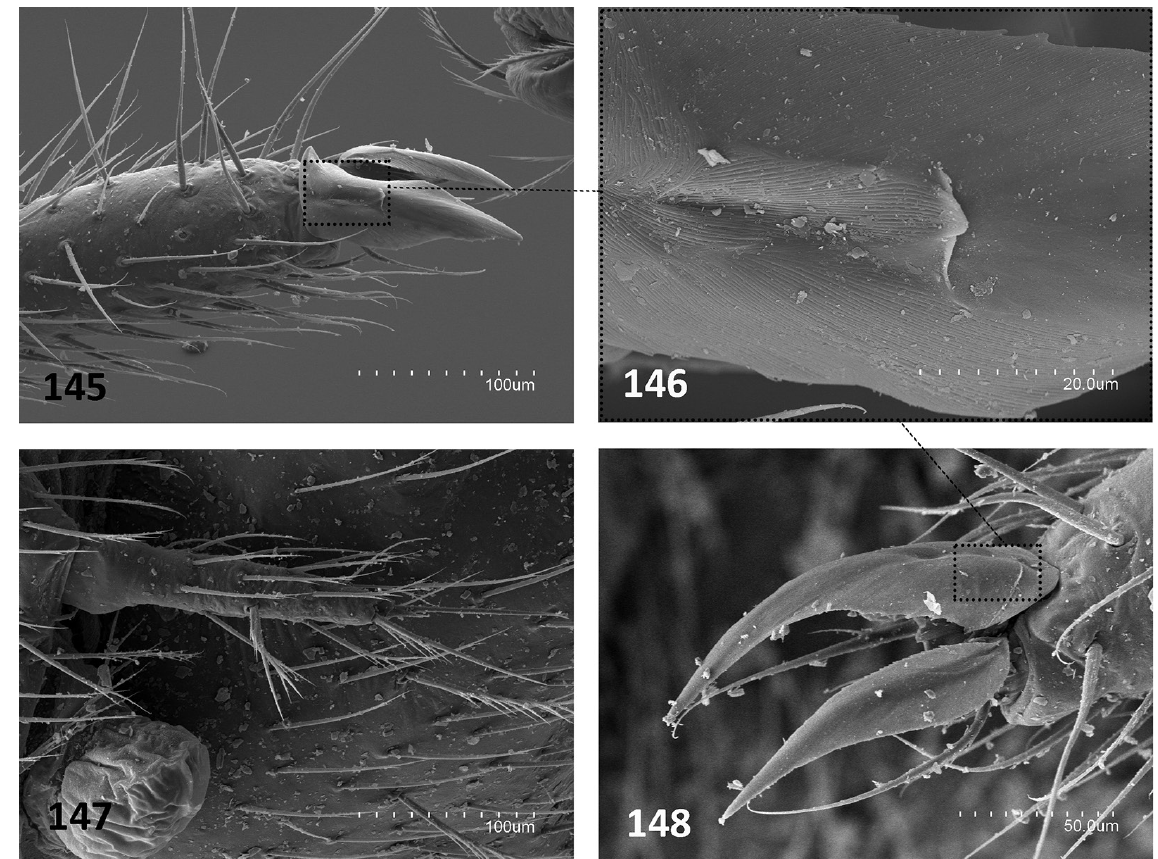
Figs 145–148. Plusiocampa ( Plusiocampa ) strouhali cavicola Vornatscher, 1943, from Odelsteinhöhle, Styria, Austria (Coll. AS). 145 . Distal portion of tarsus and pretarsus. 146 . Dorsal view of a posterior claw, detail. 147 . Lateral portion of urosternite VI with stylus and abdominal eversible vesicle. 148 . Pretarsus, laterodorsal